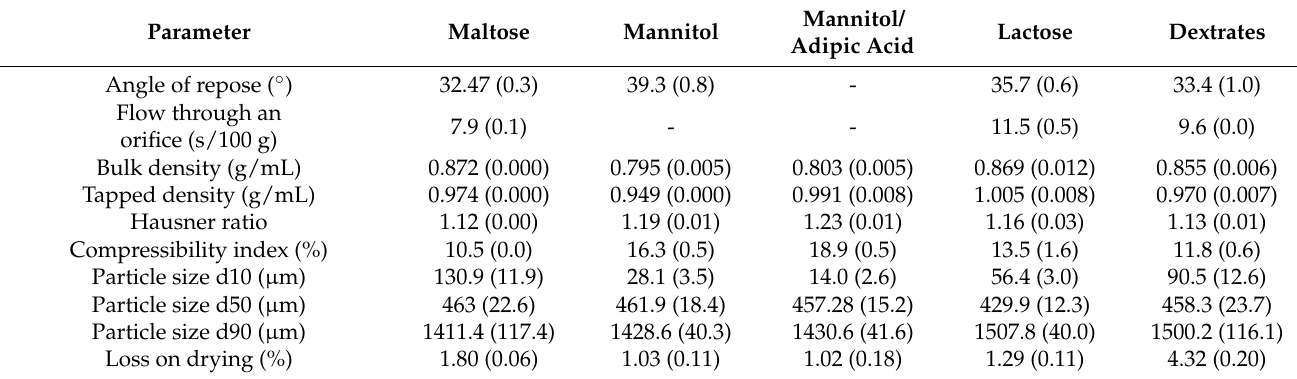
Table 6. Granular characteristics displayed as mean and